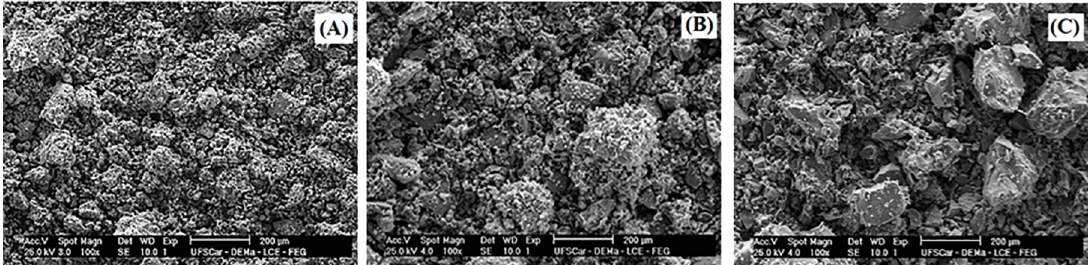
samples at 100X magnification: (a) RTO-1, (b) RTO-2, (c) RTO-3. 2